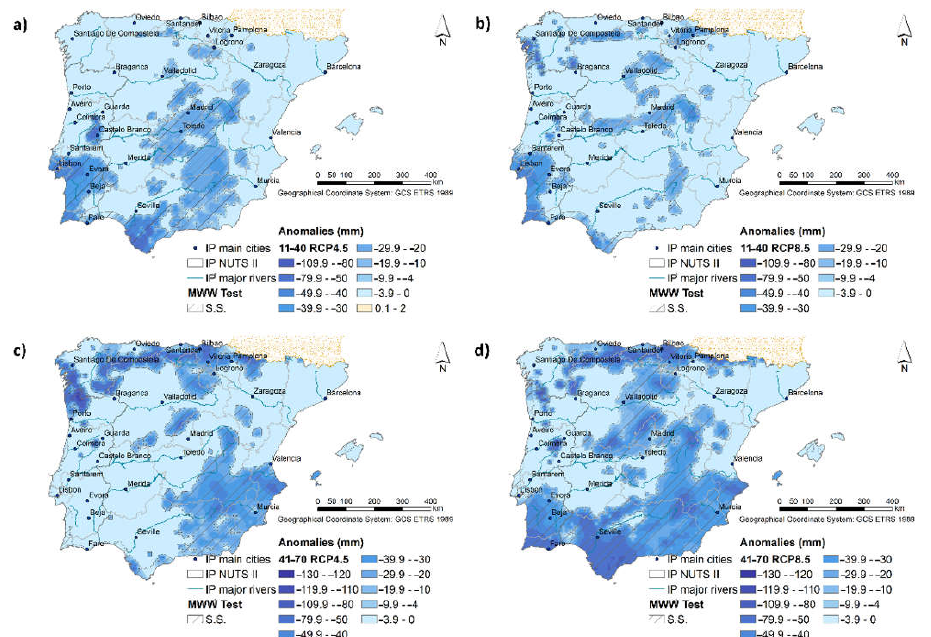
Figure 2. Total annual precipitation (mm) anomalies (Mann–Whitney–Wilcoxon test at a 5% significance level) for the period ( a , b ) 2011–2040, ( c , d ) 2041–2070, with respect to the baseline climate (1961–1990), under RCP4.5 ( left ) and RCP8.5 ( right ).